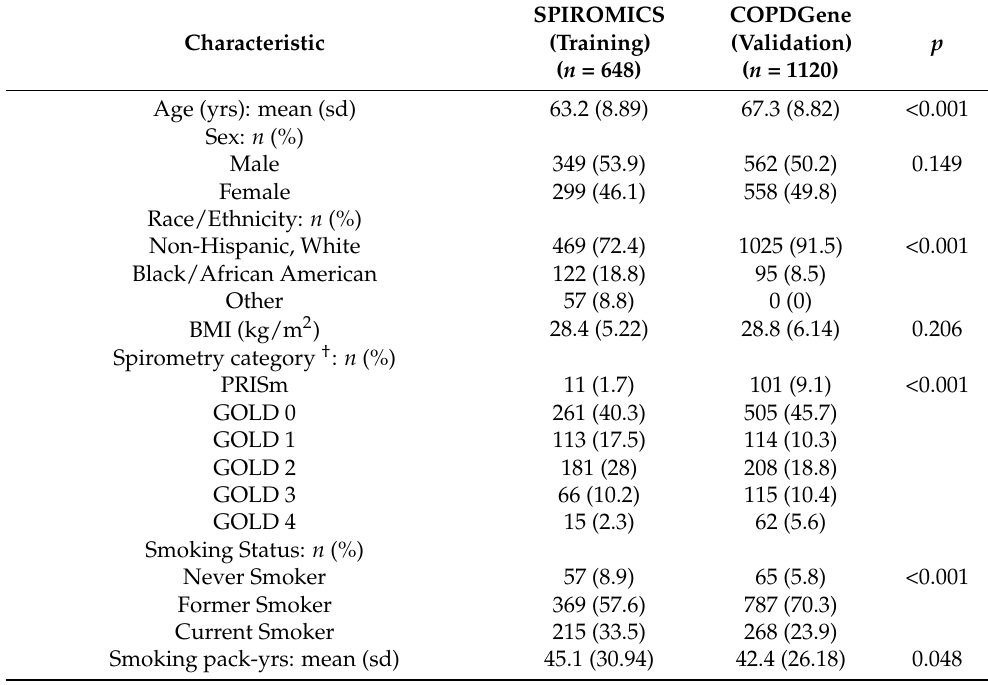
Table 1. Training and Validation Data